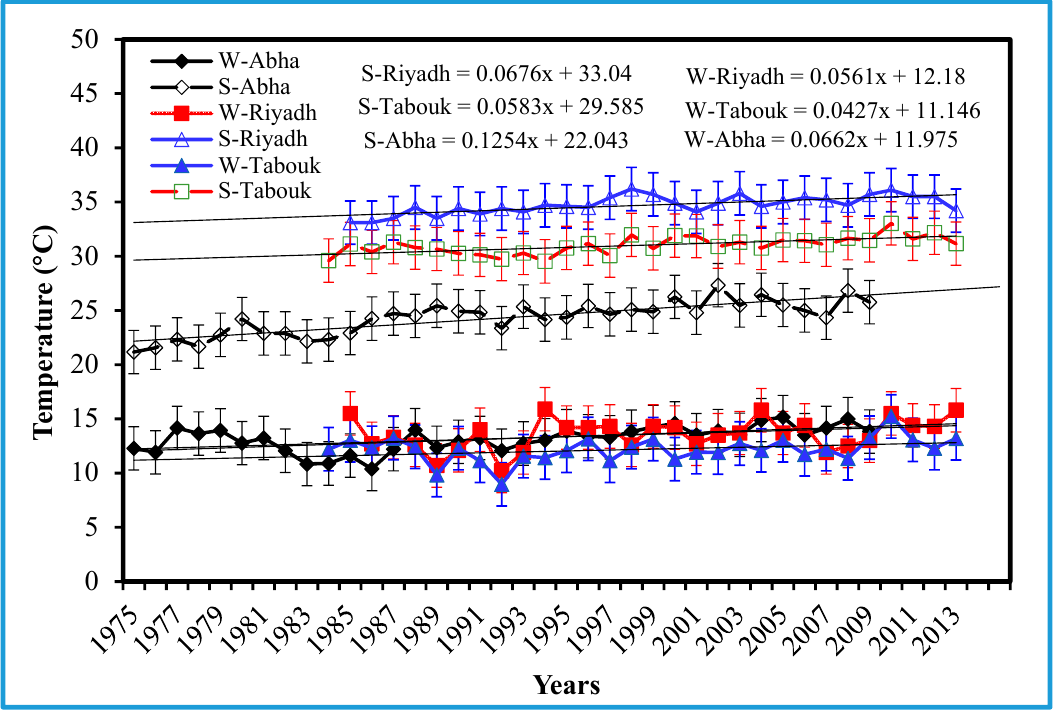
Figure 4. Linear trends of mean temperature in winter (W) and summer (S) for Riyadh, Tabouk and Abha representing the central, north and southwest regions (1984–2013); S-Riyadh: summer for Riyadh; W-Riyadh: winter for Riyadh; S-Tabouk: summer for Tabouk; W-Tabouk: winter for Tabouk; S-Abha: summer for Abha; W-Abha: winter for Abha.